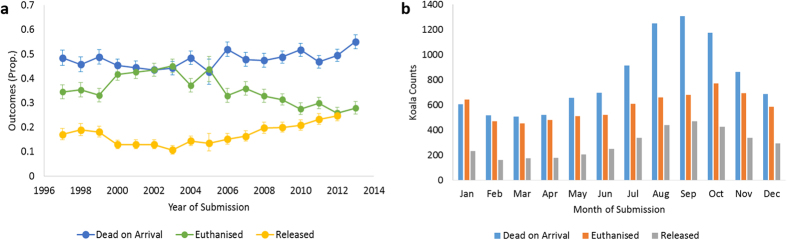
Outcomes (dead on arrival, euthanized, released) for koalas submitted to wildlife hospitals by year of submission between from 1997–2013 (No. koalas with clinical syndromes diagnosed = 20,250).The following figures display the (a) Proportion of outcomes by year of submission and (b) Counts of outcomes by month of submission.